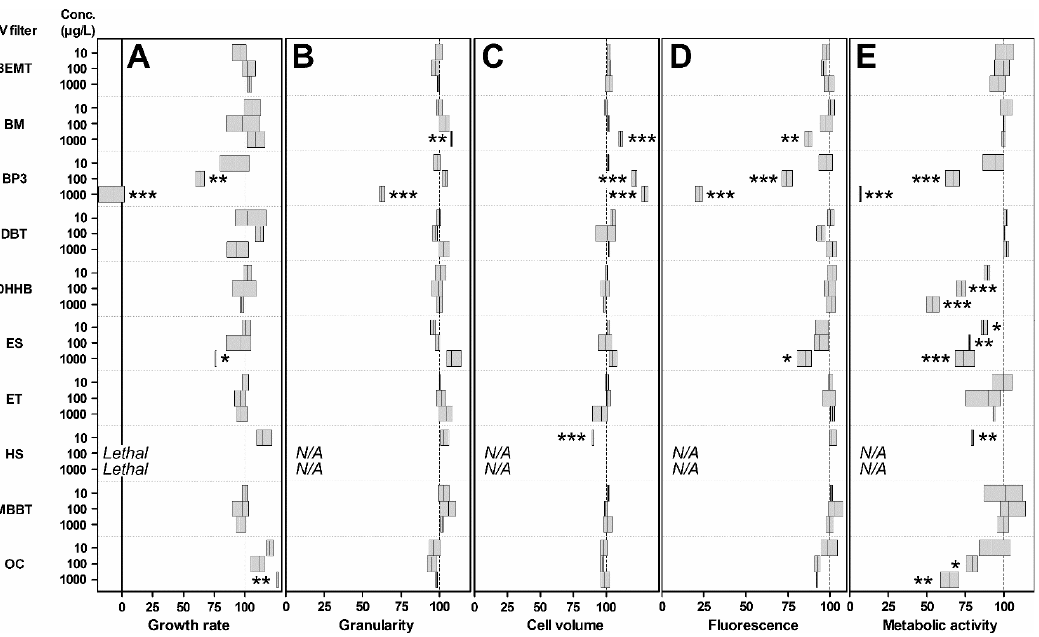
Figure 2. Relative ( A ) growth rate, ( B ) granularity, ( C ) cell volume, ( D ) fluorescence and ( E ) metabolic activity of exposed Tetraselmis compared to control, set to 100%. The boxes delineate the minimal and maximal values. The vertical line in the boxes is at mean. Significance levels relative to negative control determined by ANOVA followed by the Tukey’s multiple comparison test: *** p < 0.001, ** p < 0.01, * p < 0.05. Results were not significant unless otherwise stated. N / A: not applicable, the data could not be obtained due to extensive cell